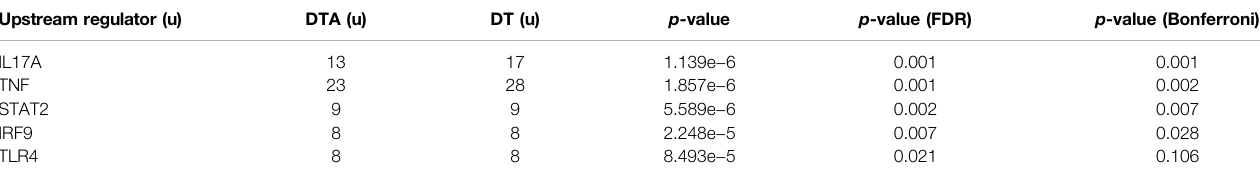
TABLE 2 | Top identi fi ed upstream regulators activated based on Bonferroni correction were listed in the table. Upstream regulator (u)